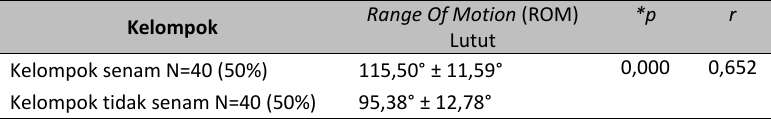
Tabel 2. Range Of Motion (ROM) kelompok senam dan tidak